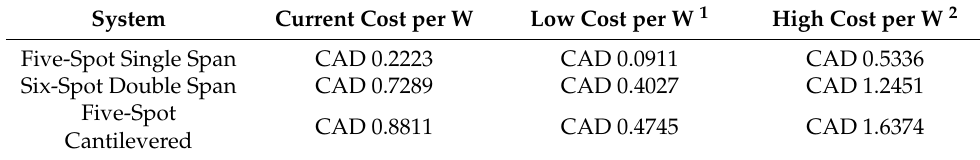
Table 9. System cost sensitivity based on material commodity prices in